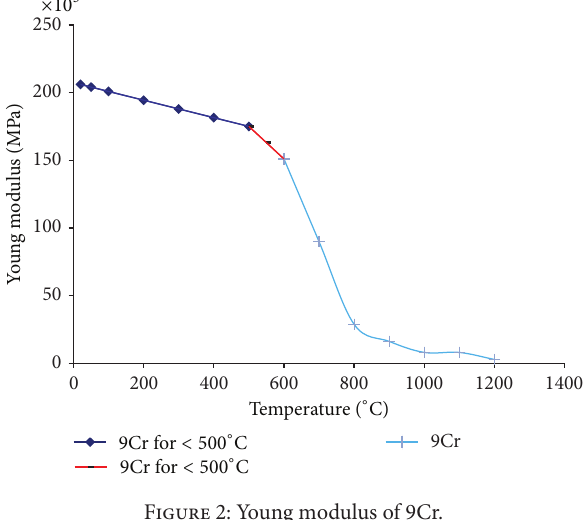
Figure 2: Young modulus of 9Cr.